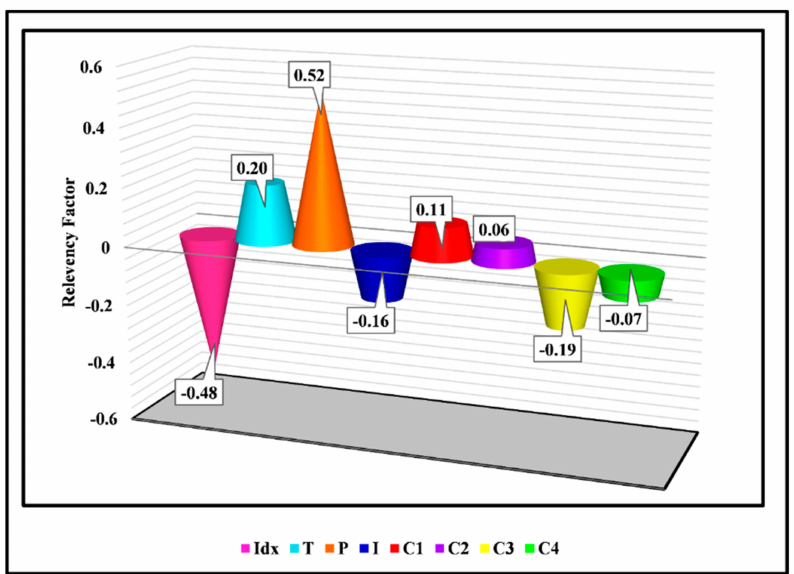
Figure 8. Sensitivity analysis for solubility of